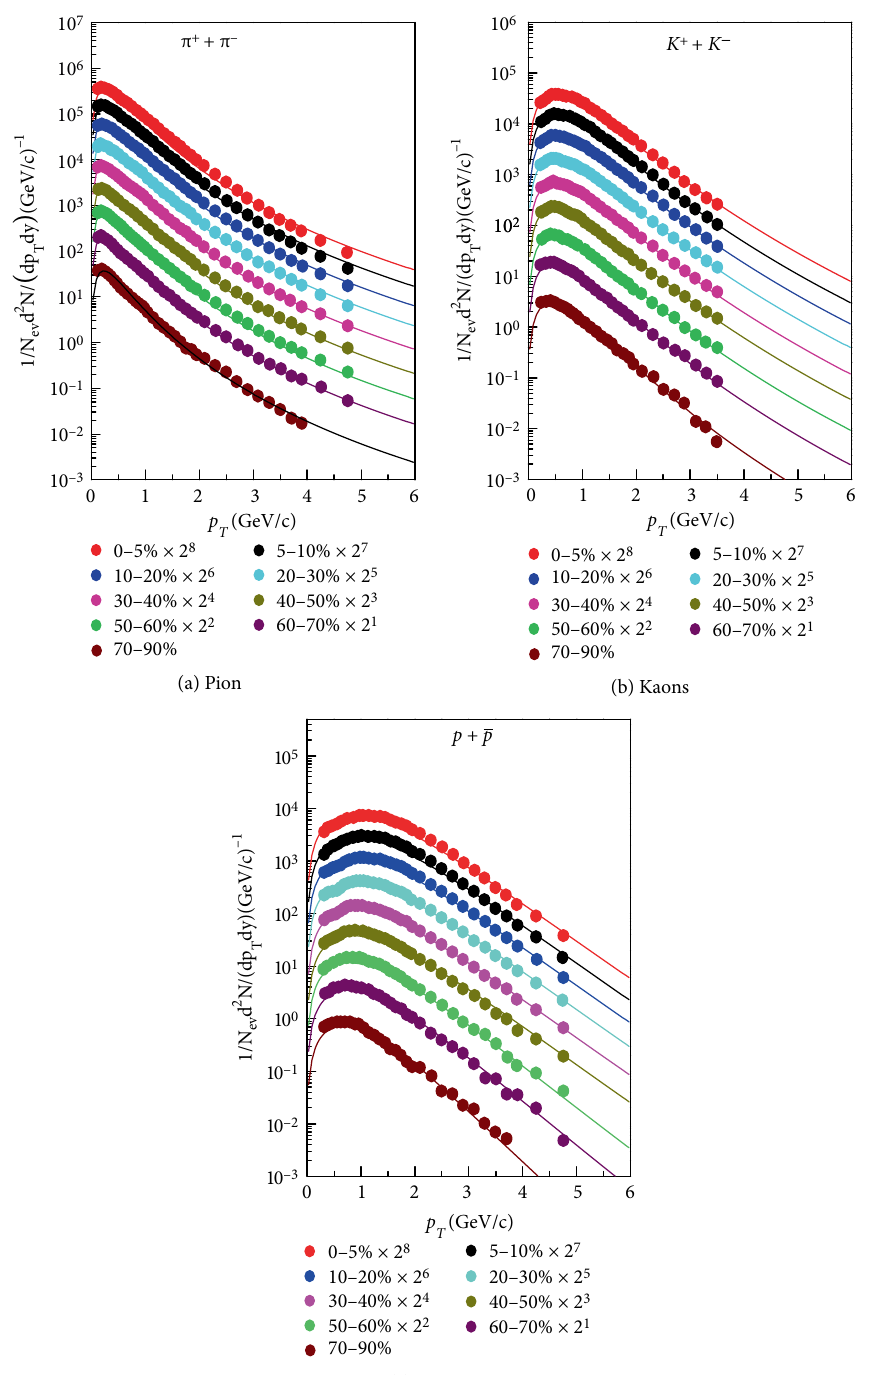
Figure 1: Transverse momentum distributions of 𝜋 , 𝐾 and 𝑝 in Xe–Xe collisions at data in nine centrality bins [5]. The lines are the results of Equation